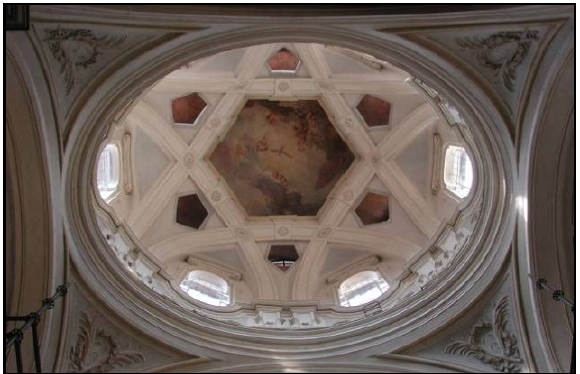
Figure 5 - Removal of the various paint layers;